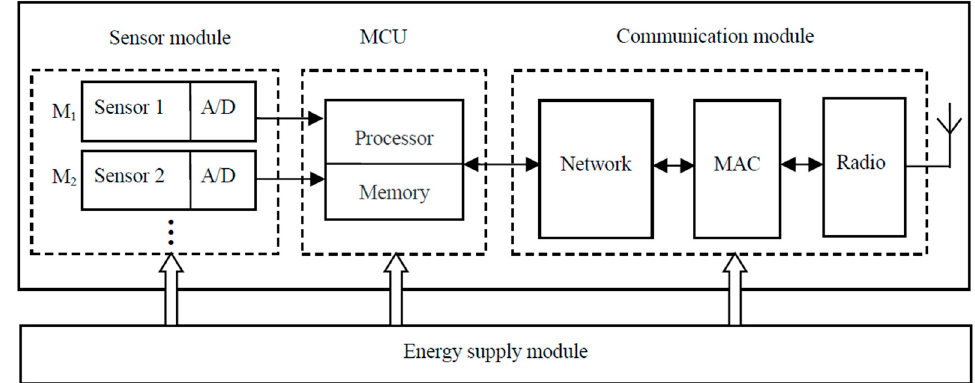
Figure 1. Structure of a sensor node. Table 1. Useful sleep states for sensor node.